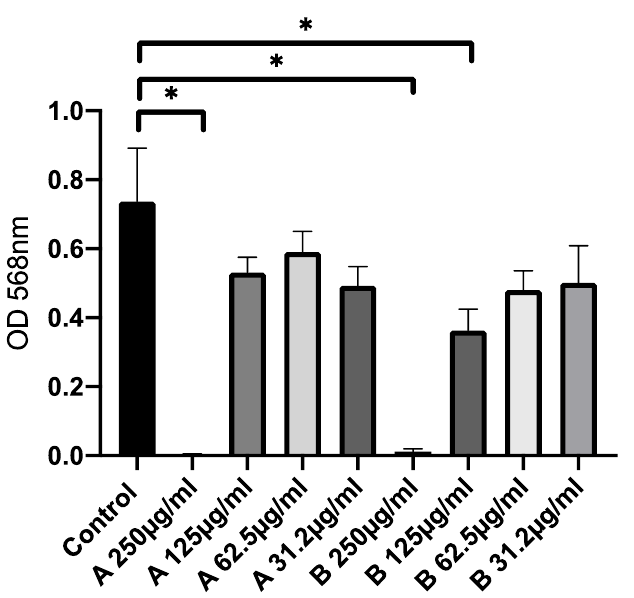
Figure 9. Cytotoxic activity of CIP-loaded niosomes (OD values). MTT assay on human bladder cancer cells (T24). Data were expressed as mean ± SD. All considered conditions were compared to untreated control. * p value ≤ 0.05.